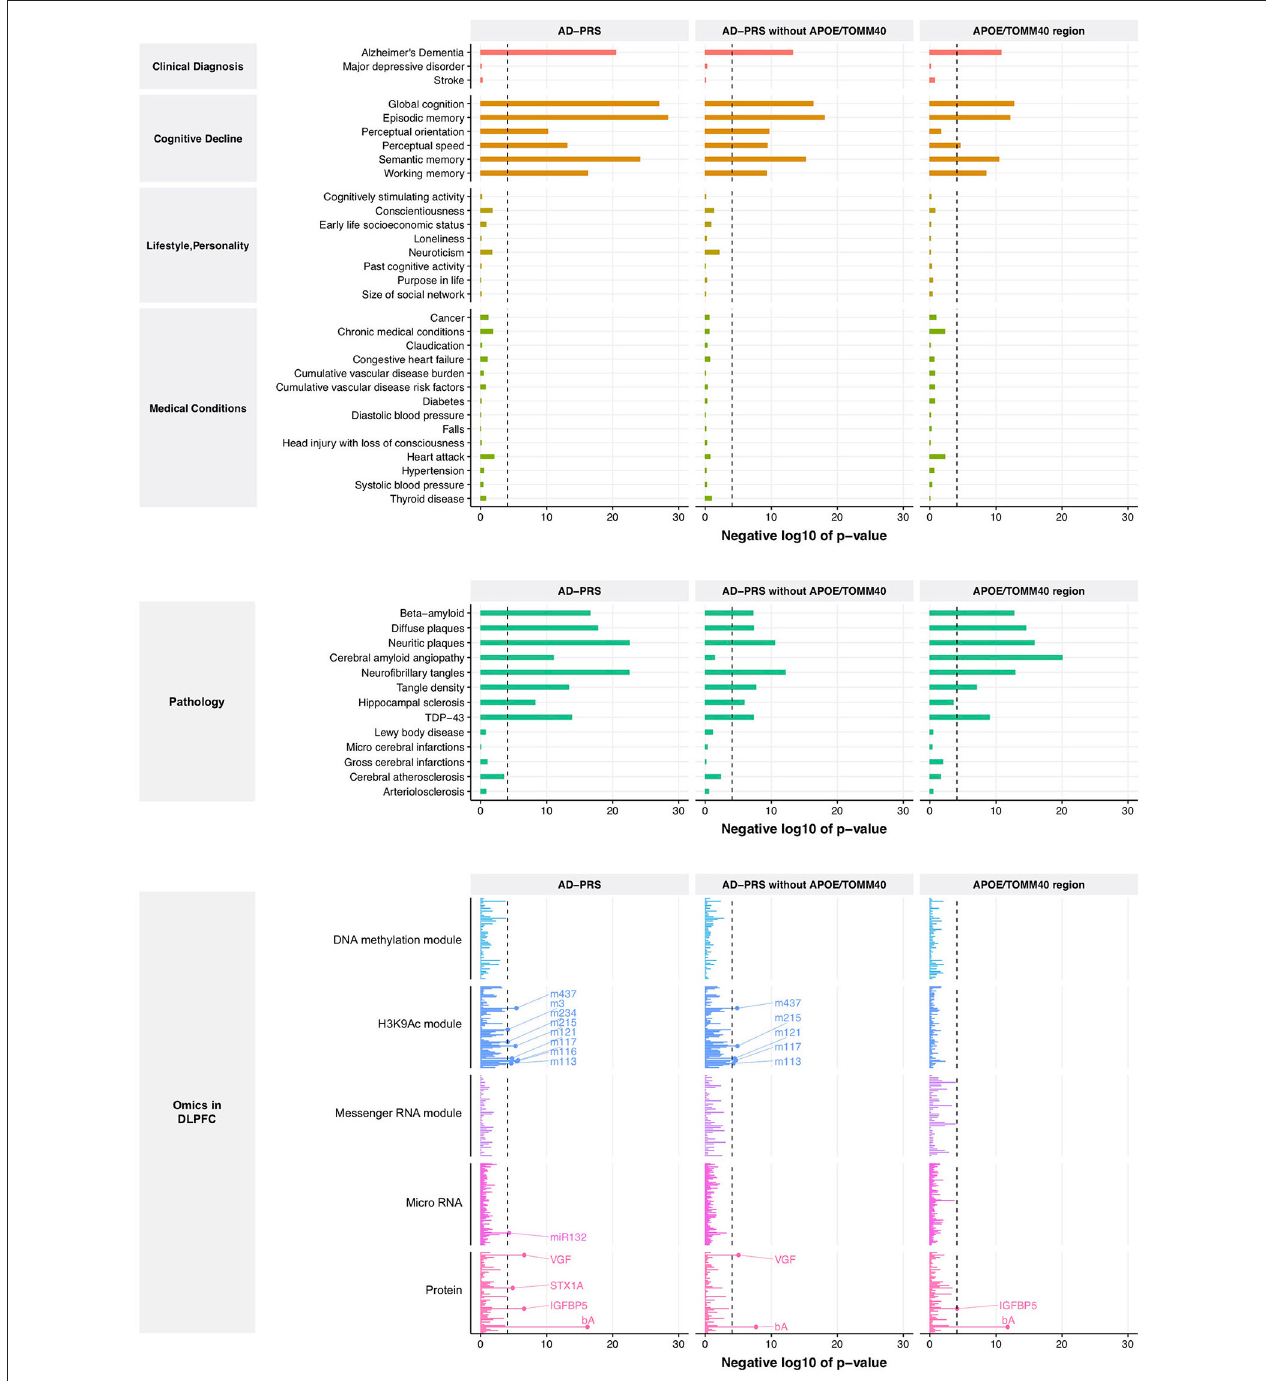
FIGURE 1 | Association between AD-PRS and clinical phenotypes, neuropathologies, and molecular signatures. A dash line represents Bonferroni-corrected p -value at 0.05.